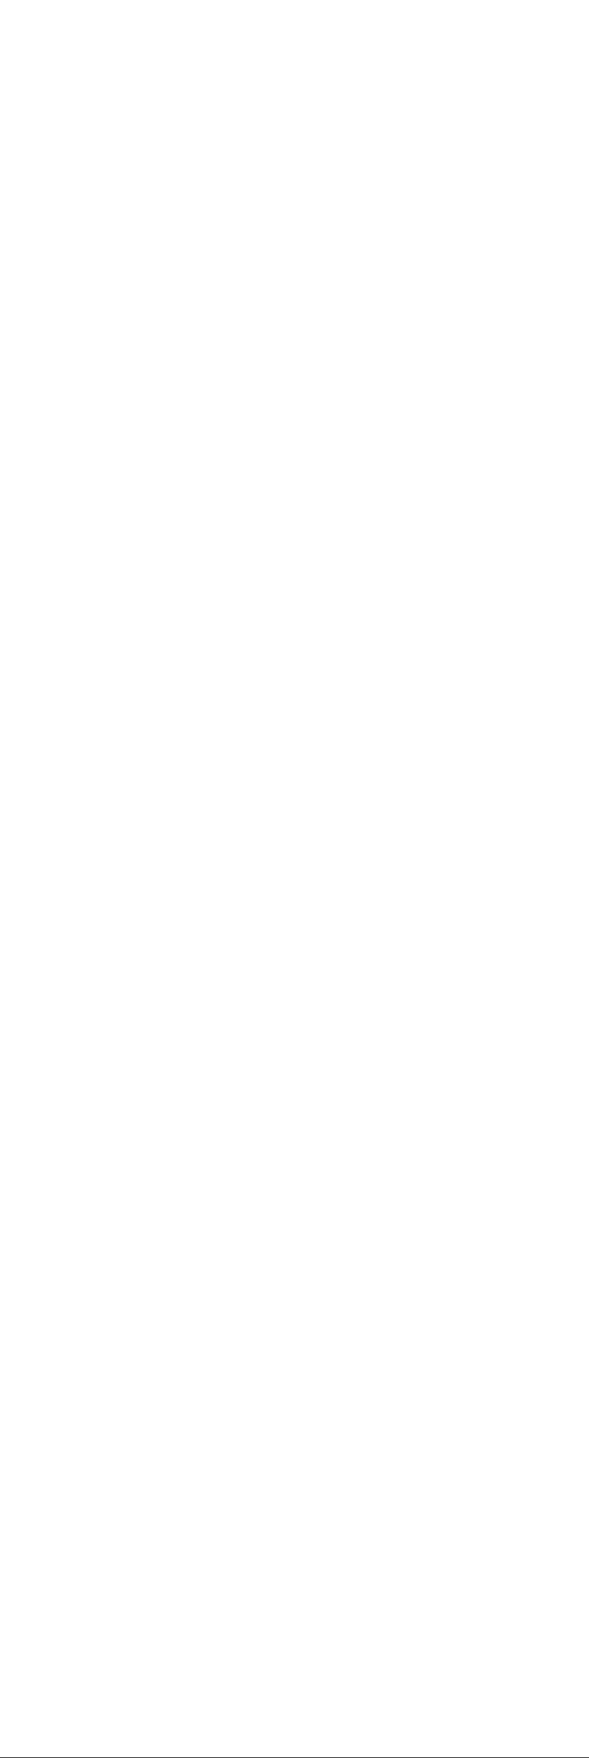
Table I : Breast milk intake (ml.) at different stages of